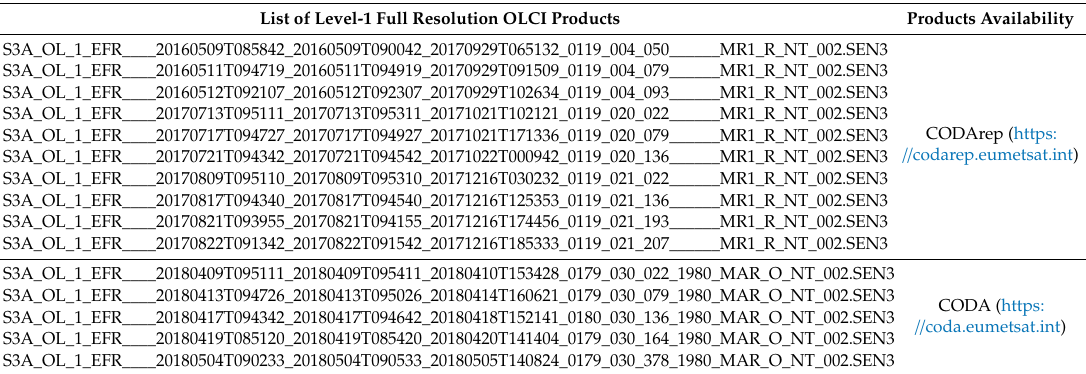
Table 3. List of Level-1b products used for the match-up analysis.